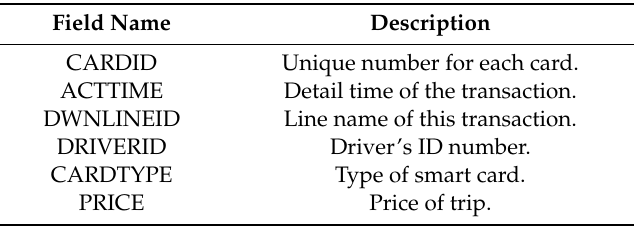
Table 1. Data structure of